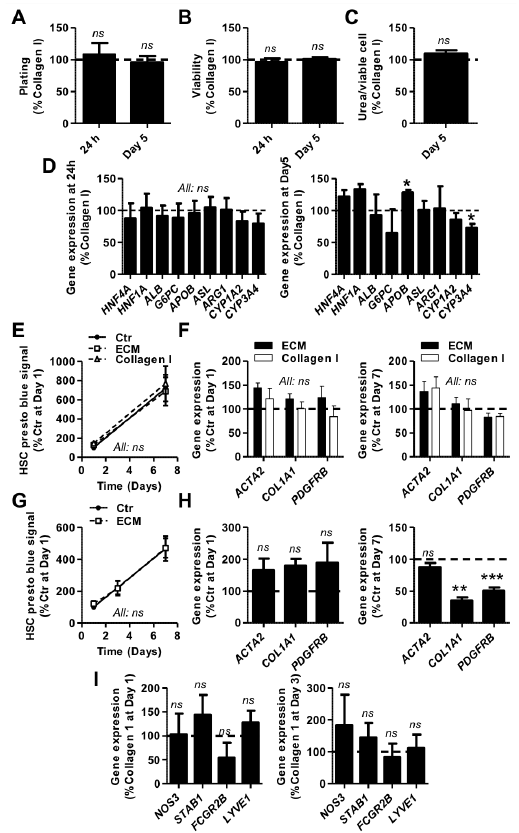
Figure 3. Human liver cell culture on a solubilized HL-ECM coating. ( A – D ) Hepatocytes (HEPs) from 3 donors (32, 155 and 158) were seeded on rat tail collagen I (Collagen I)- and solubilized human liver extracellular matrix (ECM)-coated tissue culture plastic and maintained in culture for up to 5 days. ( A ) Plating was evaluated after 24 h and 5 days of culture by DNA dosage. ( B ) Viability was evaluated after 24 h and 5 days of culture by resazurin reduction. ( C ) Urea was measured in culture supernatant after 5 days of incubation and normalized to viable HEP number. ( D ) Expression of key markers of hepatocyte functions was assessed by qPCR after 24 h and 5 days of culture (right panel: only statistically significant di ff erences are indicated). ( E , F ) HSCs from 3 donors (94, 97 and 98) were grown on tissue culture plastic surface (i) uncoated (Ctr) or (ii) coated with solubilized human liver ECM or (iii) with a rat tail collagen I solution. ( E ) The number of viable HSCs over time was evaluated by resazurin reduction. ( F ) Gene expression was evaluated after 24 h and 7 days of culture by qPCR for markers of activated HSCs. ( G , H ) HSCs from 3 donors (94, 97 and 98) were grown on a tissue culture plastic surface in culture medium (i) non-supplemented (Ctr) or (ii) supplemented with 100 µ g / mL solubilized human liver ECM. ( G ) The number of viable HSCs over time was evaluated by resazurin reduction. ( H ) Gene expression was evaluated after 24 h and 7 days of culture by qPCR for markers of activated HSCs. ( I ) (LS)ECs from 3 donors (156, 164 and 173) were seeded at the same density on rat tail collagen I- and solubilized human liver ECM-coated tissue culture plastic and maintained in culture for up to 3 days. Gene expression was evaluated after 24 h and 3 days of culture by qPCR for EC and LSEC markers. All: n = 3, results were analyzed per donor, graphs show mean ± SEM, results are expressed as % Collagen I or % Ctr, Student’s t -test (All except E and G ) or 2-way ANOVA with Bonferroni’s post-hoc test ( E and G ) versus Collagen I or Ctr value, ns p > 0.05, * p < 0.05, ** p < 0.01, *** p < 0.005.